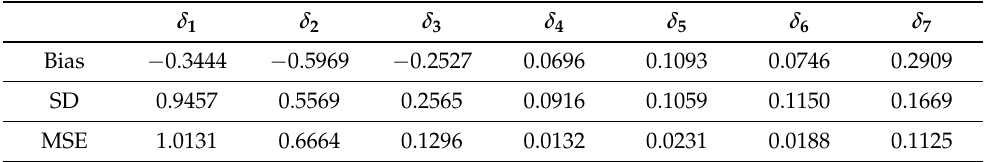
Table 3. Bias, SD and MSE evolutions with respect to the parameter δ variation for PLGSIMF with the identity link function and n =